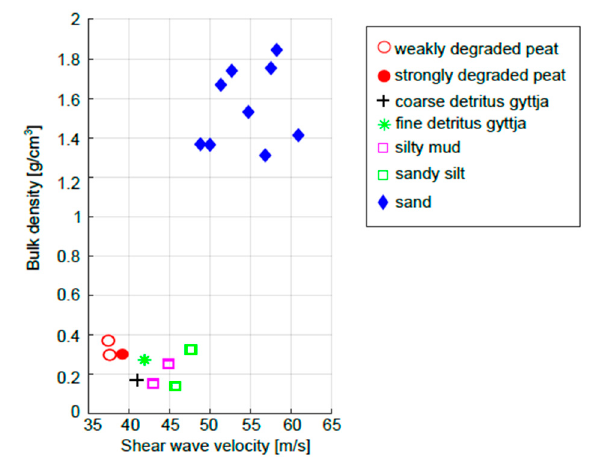
Figure 11. Shear wave velocity versus bulk density regarding core I.2bis.